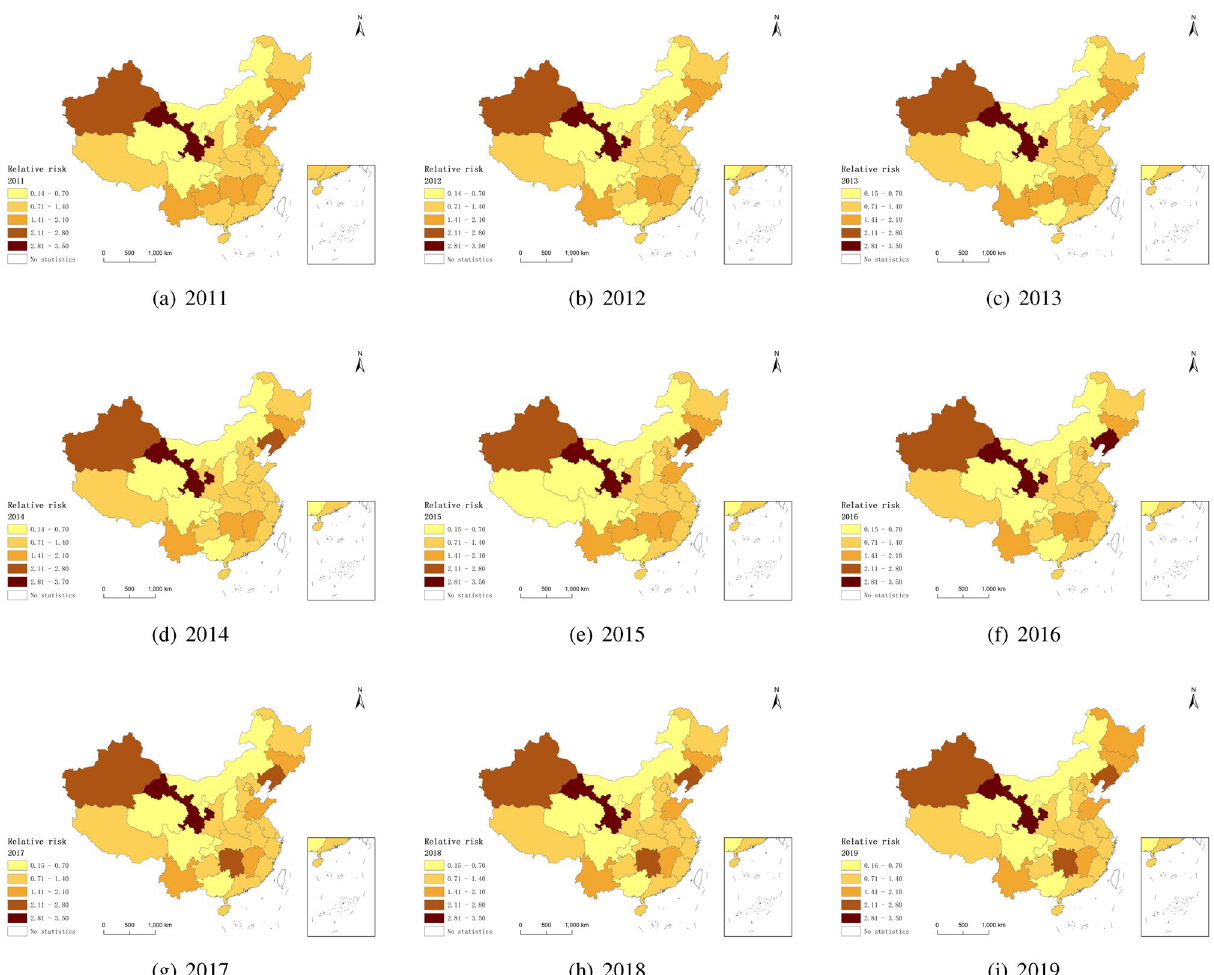
Figure 3. The relative risk under the combined effects of spatio-temporal interaction on two